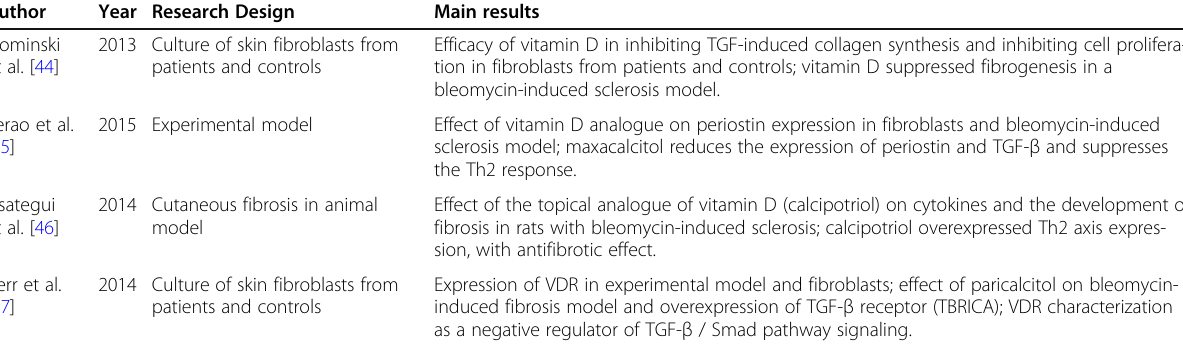
Table 2 Characteristics and results of the selected experimental models of systemic